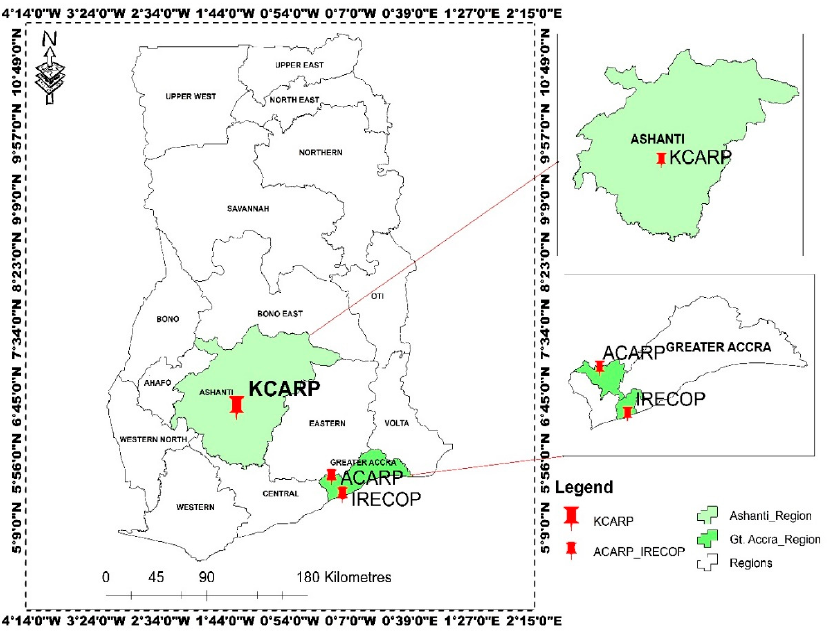
Figure 1. Map of Ghana showing the study area (created by the authors).